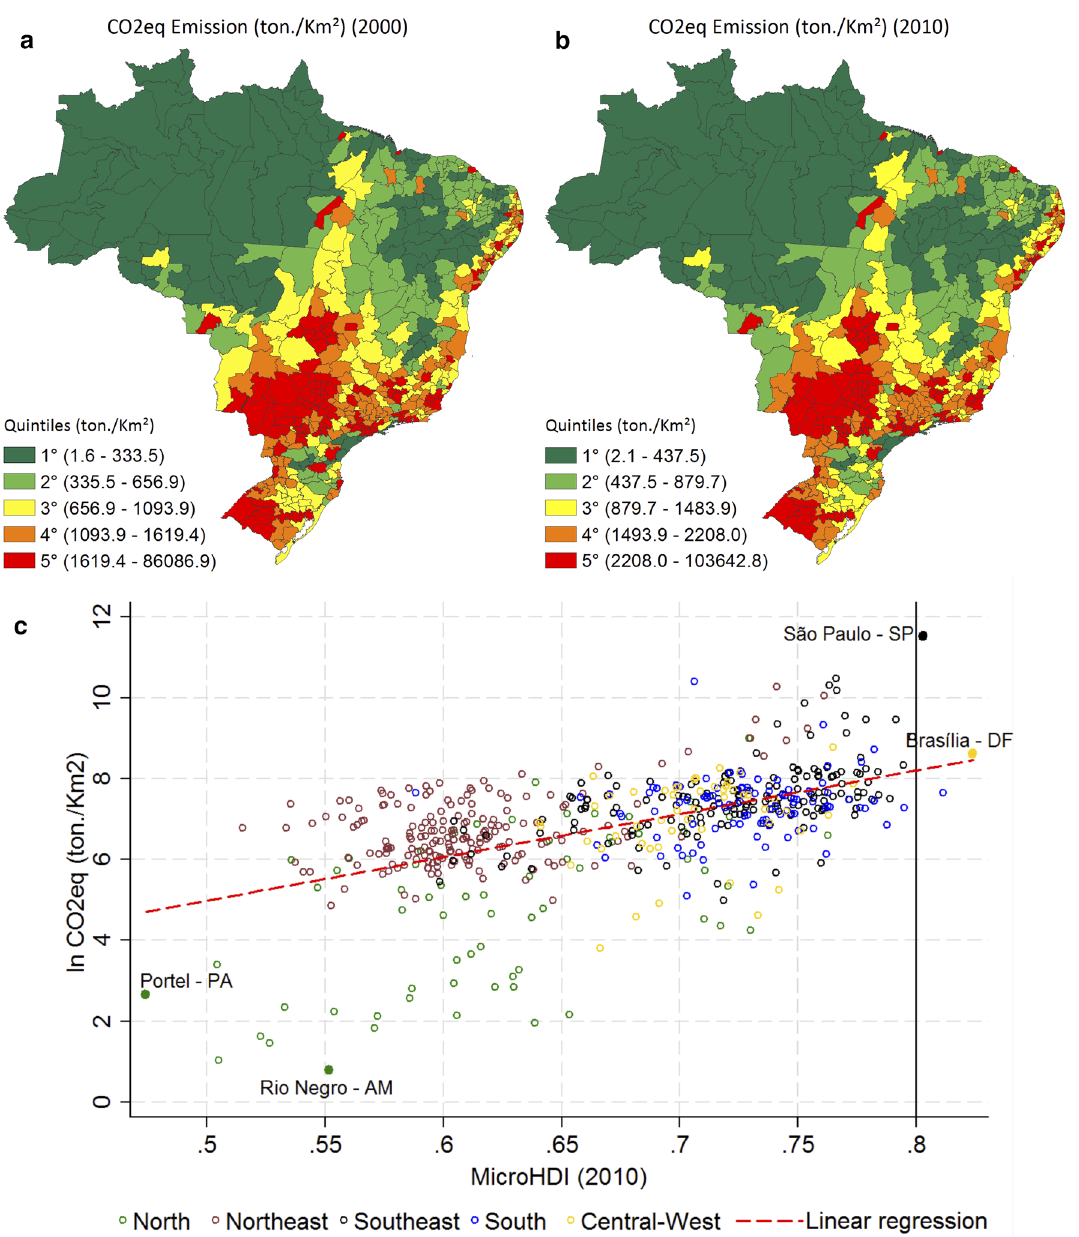
Fig. 2 CO eq emissions trends and their relationship with MicroHDI for Brazil. CO 2 km 2 ) in 2010 ( b ). Correlation between MicroHDI and CO all values. The correlation coefficient is 0.55. The vertical dashed line represents the MicroHDI value of 0.8 representative of a very high development